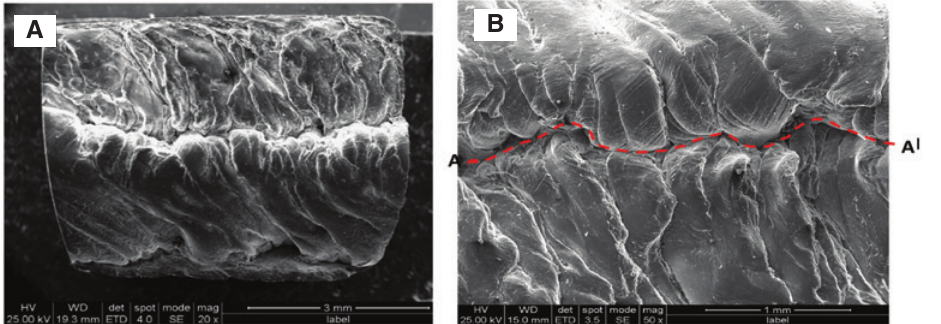
Figure 15: SEM fractographs images of tensile fracture surface (Al alloy side). Fractograph (B) indicating the wavy line (red color) through which initiation of fracture occurred, see also Figure 14. (A) Al alloy side fractograph. (B) Enlarged